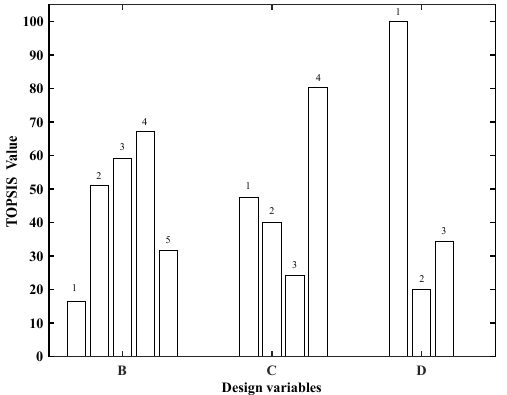
Figure 13. TOPSIS evaluation of rotor disk.